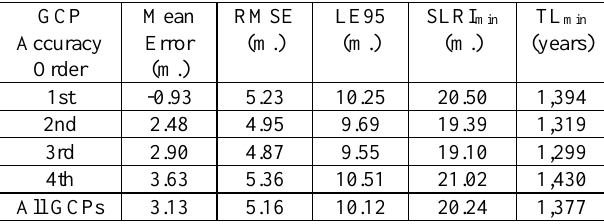
Positioning Accuracy Standards Part 3: National Standard for Spatial Data